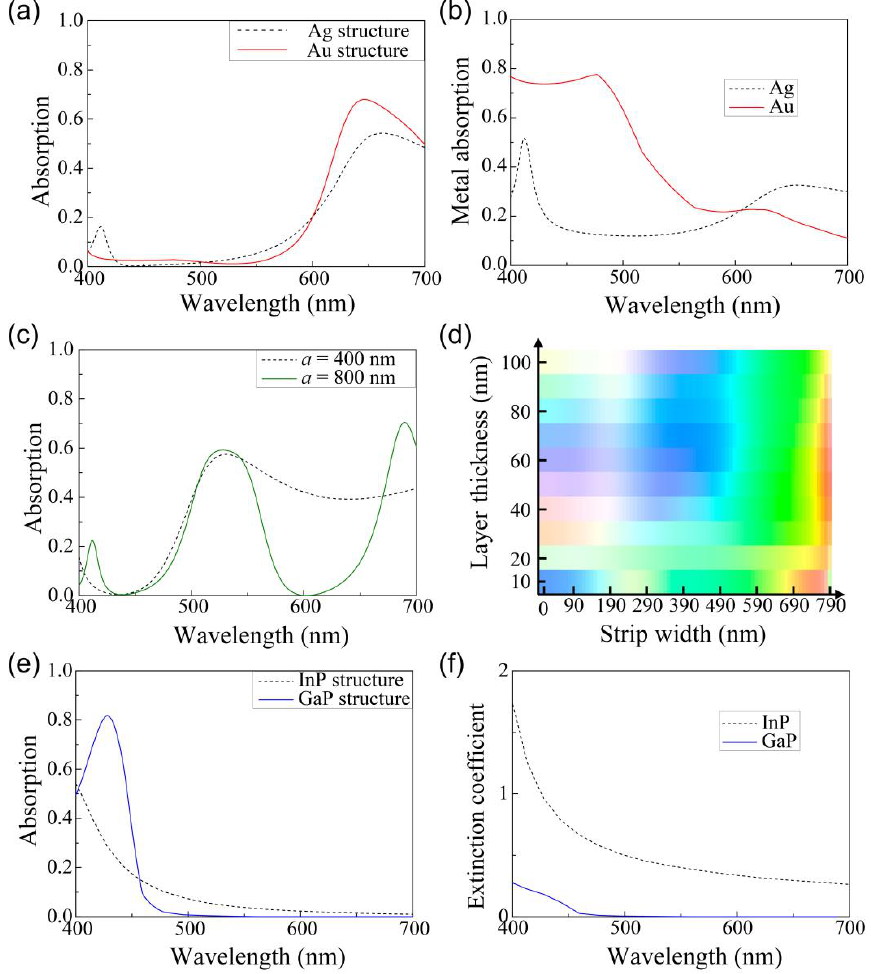
Figure 4. Absorption spectrums of the absorption semiconductor layer in the three representative structures (black dotted lines) of Figure 3 and the three additionally optimized structures (red, green, and blue solid lines) for the colors of ( a ) red, ( c ) green, and ( e ) blue. The red optimized structure has the structure parameters of w = 331 nm and t = 44 nm, in which Ag is replaced by Au. The green structure ( w = 669 nm, t = 96 nm) has a different period of the Ag strips ( a’ = 800 nm), and the blue structure ( t = 64 nm) has a gallium phosphide (GaP) layer as the absorption layer instead of the InP layer. ( b ) Absorption spectrums of the metals, Ag (black dotted line) and Au (red line), in the structures detecting the red color. ( d ) Colors detected by the structure with a double period a’ of 800 nm for various strip widths and InP layer thicknesses. ( f ) Imaginary part of the refractive index for the absorption layers, InP (black dotted line) and GaP (blue line).